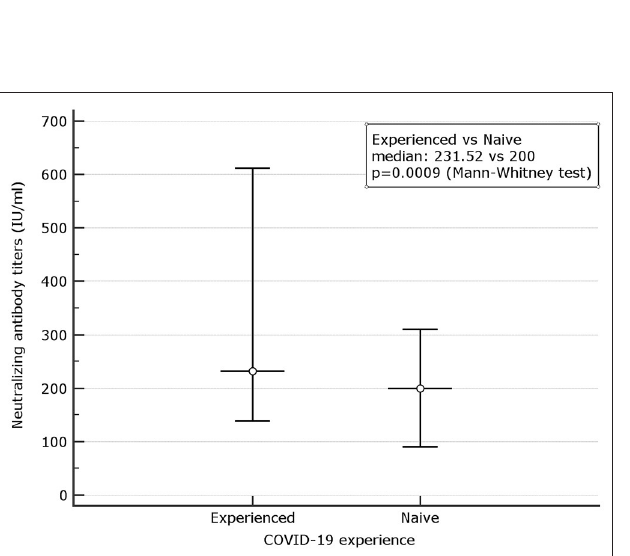
FIGURE 3 | Comparison between microneutralization results in naive and experienced. Mean and Interquartile ranges ( IQR ) are reported ( p = 0.0009).